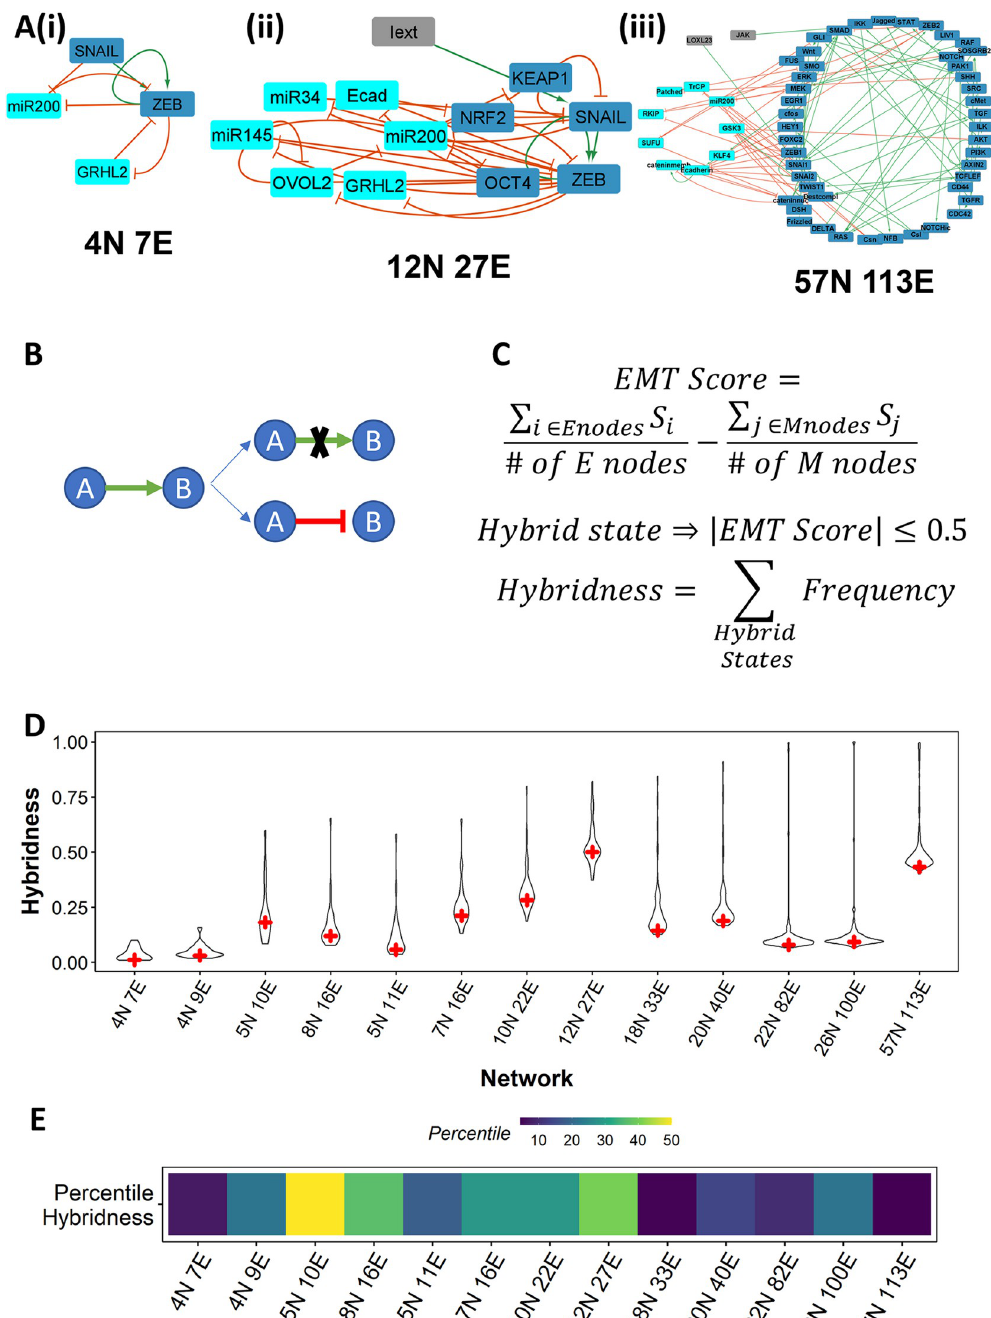
Fig 1. EMP networks show weak hybridness. (A) EMP network topologies analyzed here. (B) Depiction of two types of edge perturbations–edge deletion and edge-sign reversal. (C) Formula for the calculation of Hybridness for a network. Enodes and Mnodes are Epithelial and Mesenchymal nodes in the network, respectively and S i is the binarized expression level (0 or 1) of node i in state S . "# of Enodes " and “# of Mnodes ” are the number of Epithelial and Mesenchymal nodes, respectively. Frequencies of hybrid states are normalized by the total frequency count of all the steady states for any network. (D) Violin plots showing the distributions of hybridness obtained from RACIPE simulations for the ensemble of perturbed networks. The ‘+’ sign indicates the hybridness of the corresponding EMP (WT or unperturbed) network. (E) Percentile hybridness of WT EMP networks in the distributions shown in Fig 1D.